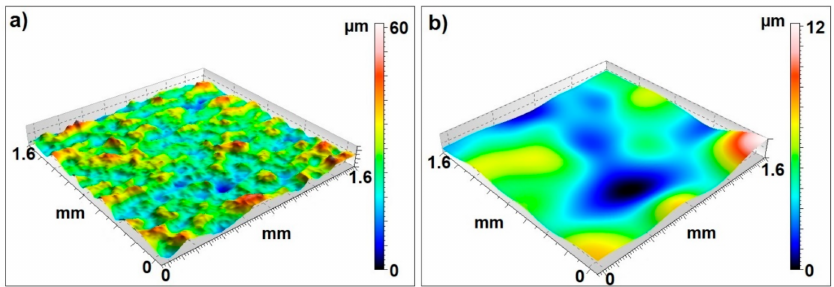
Figure 5. 3D Lateral surface topography: ( a ) surface before filtering, ( b ) surface